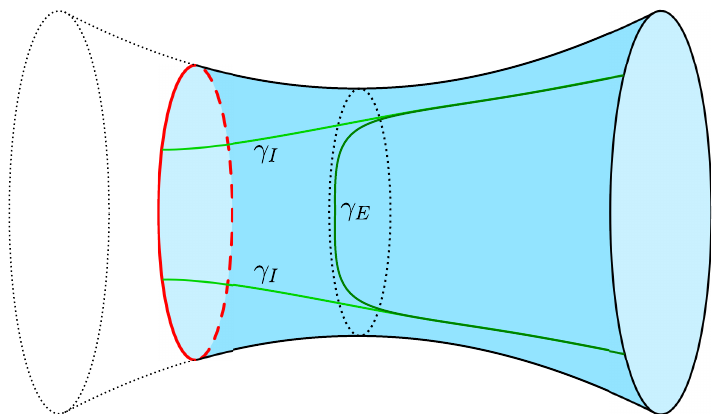
Figure 5. For a brane in an eternal black hole spacetime, when we consider a subregion of the CFT on the boundary, the RT surface is either outside the horizon or crosses the horizon and ends on the brane. For large black holes, the surface outside the horizon has a portion which lies along the horizon, whose area can be interpreted as entropy of the mixed state on the